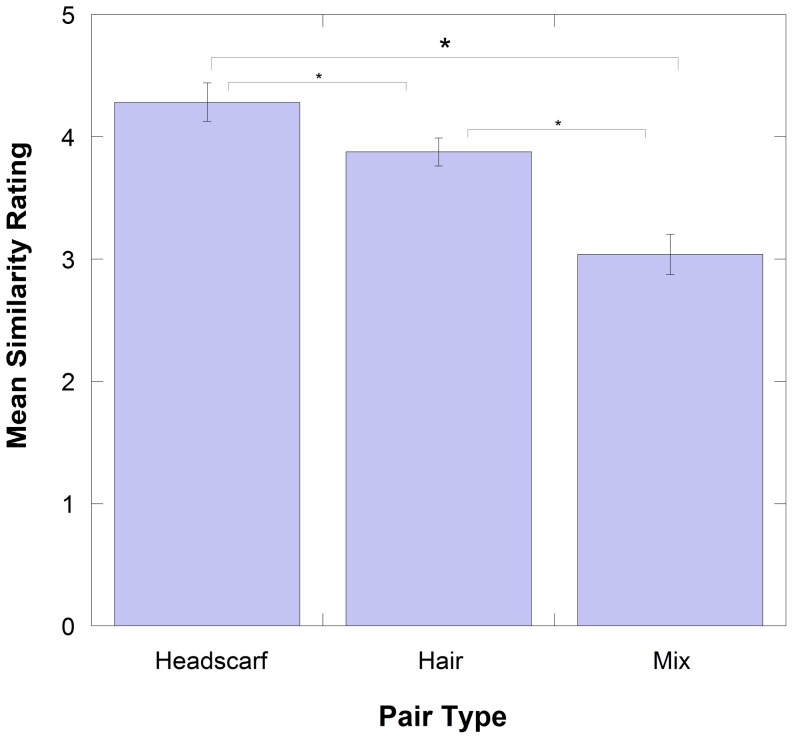
Mean similarity ratings for the different types of pairs.Error bars represent Standard Error. * is significance at p<0.001.